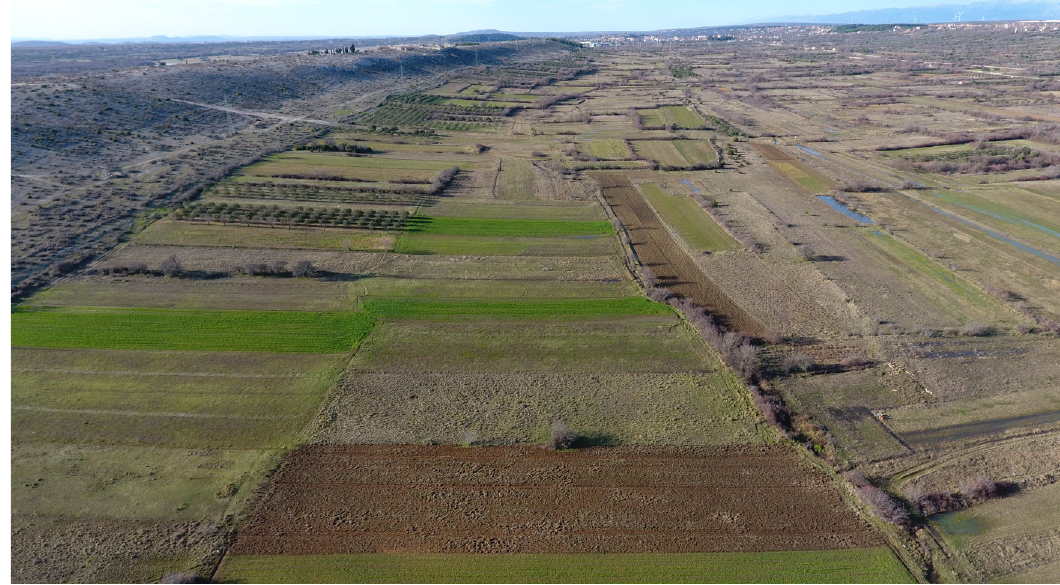
Figure 3: One part of the typical valley in the area of the Northern Dalmatia ( photo: M. Grguri ć )